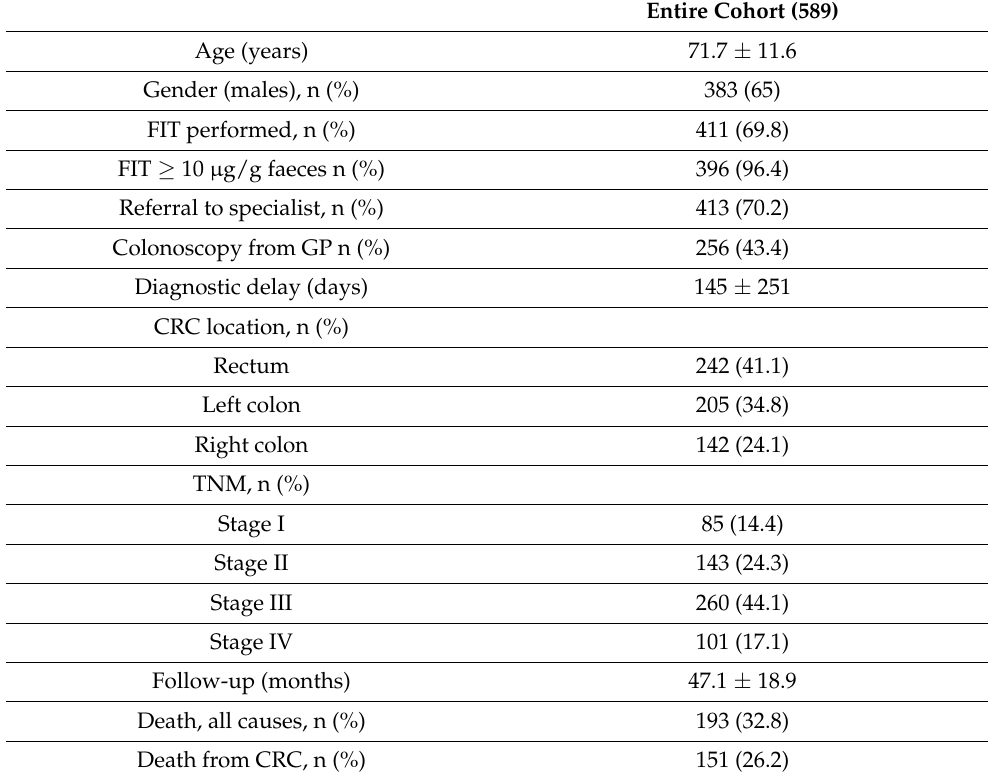
Table 1. Description of patients included in